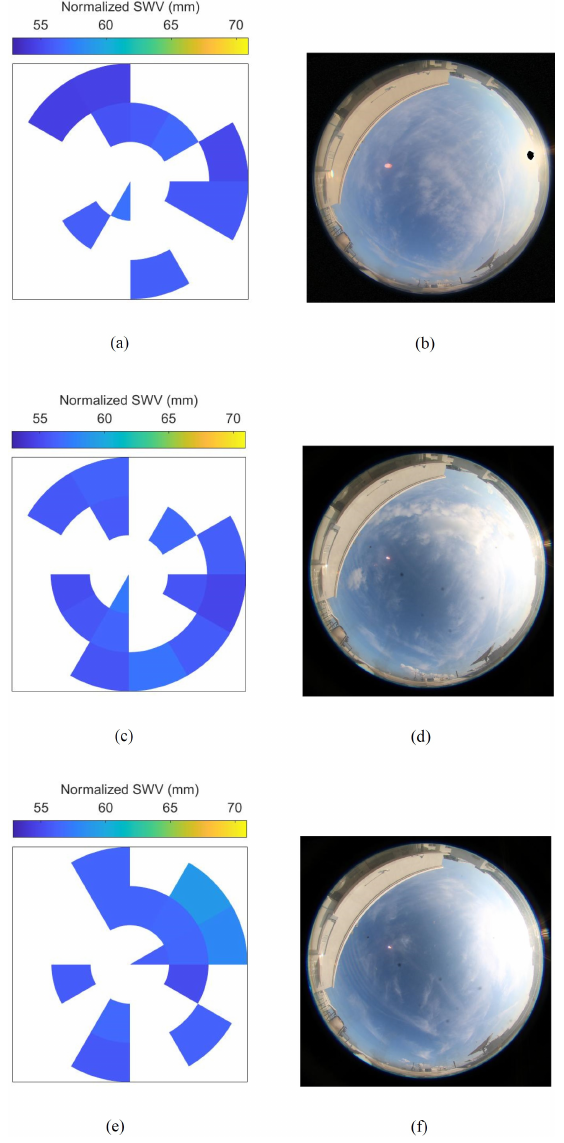
Figure 6. Left: Spatial plots of normalized SWV on 20 April 2016 at ( a ) 08:00, ( c ) 08:20, and ( e ) 08:40 local time. Right: Sky images on the same day, at the corresponding ( b ) 08:00, ( d ) 08:20, and ( f ) 08:40 local